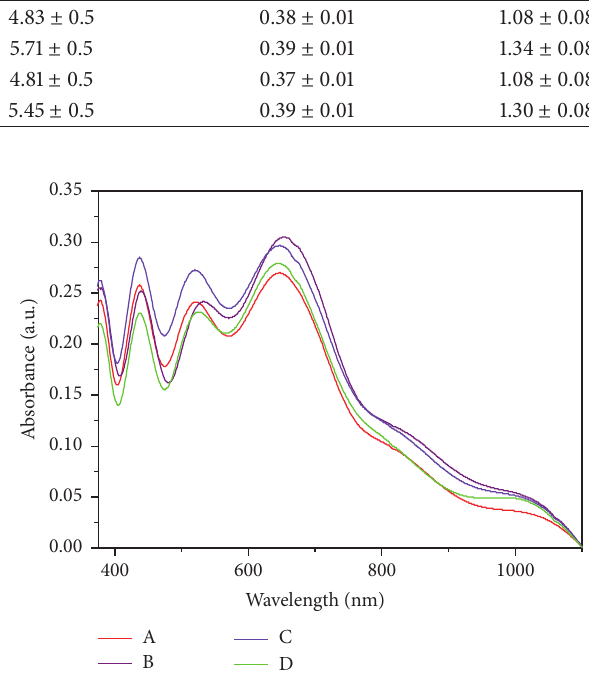
Figure 4: UV spectra of PCPDTTBTT:PCBM blend films on glass substrate: A: without thermal annealing, B: thermal annealing at 80 ∘ C, C: thermal annealing at 100 ∘ C, and D: thermal annealing at 120 ∘